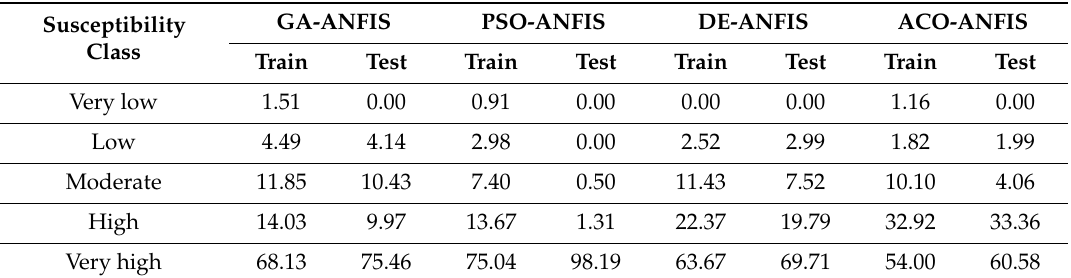
Table 2. The percentage of the training and testing landslides in each susceptibility classes.